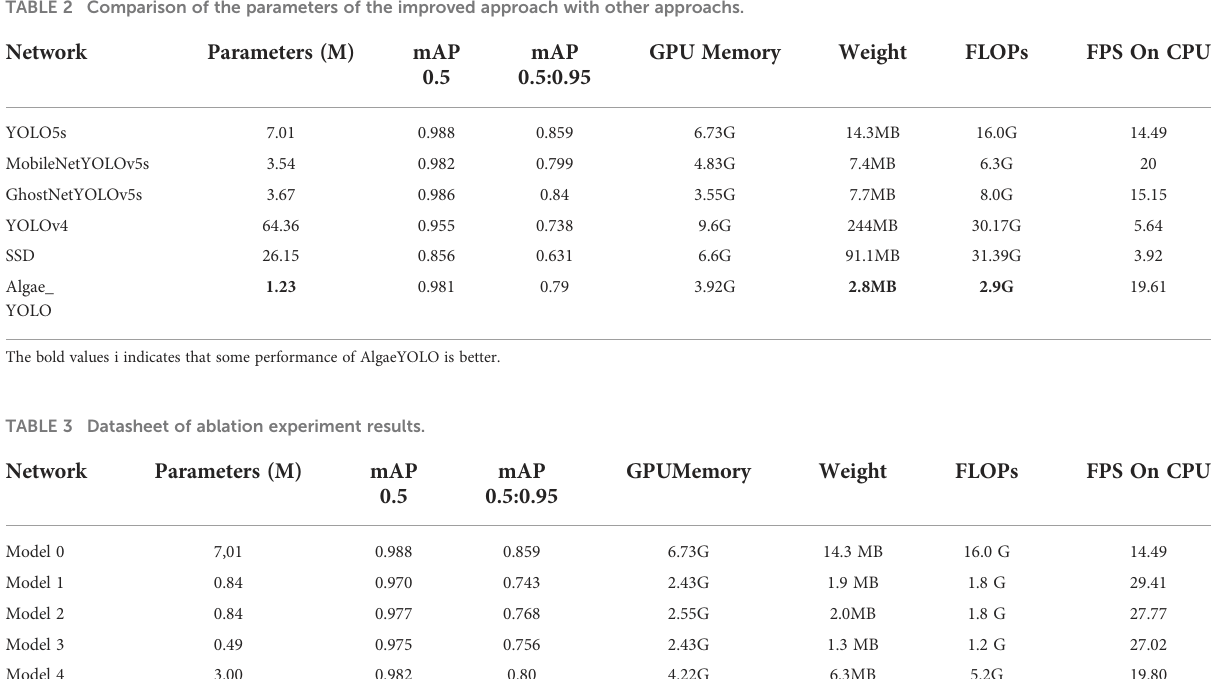
TABLE 2 Comparison of the parameters of the improved approach with other